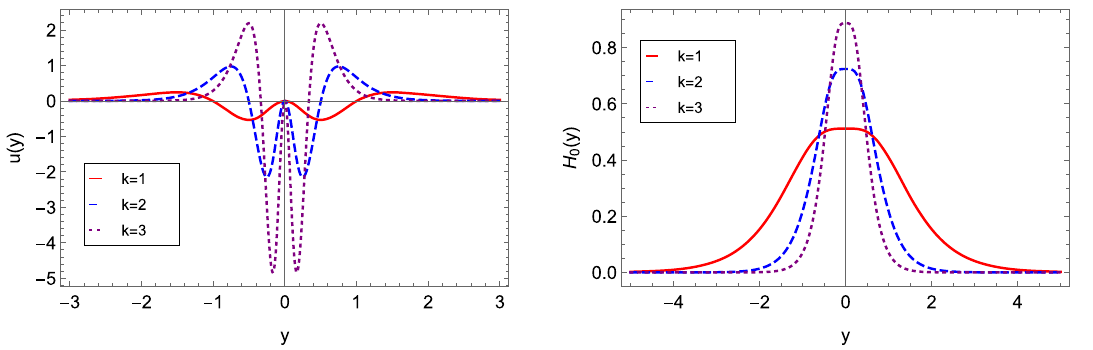
Fig. 8 Potential u ( y ) (left panel) and graviton zero mode H 0 ( y ) (right panel) for the solutions described in Sect. 3.2 with ϕ 0 = 2, ψ 0 = 1, A 0 = 1 and V 0 = 1. The shape of the potential U is always a double well. The finiteness of the integral of H 0 implies that the zero graviton mode is localized on the brane